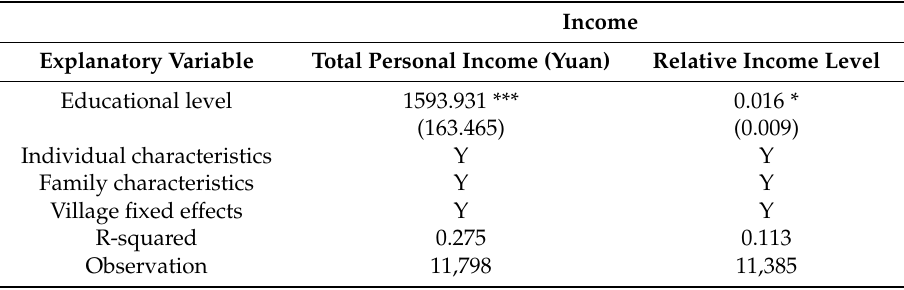
Table 8. The impact of education on personal income (OLS).